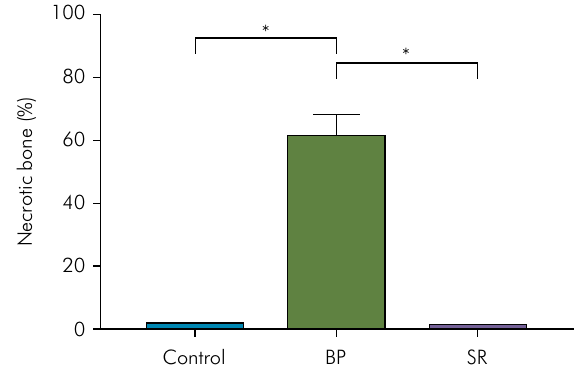
(Mean ± SEM) *p < 0.05 (Kruskal–Wallis, followed by Dunn’s test). Figure 6. Incidence of MRONJ based on rate of necrotic bone. Necrotic bone was present only in the BP group. No evidence of osteonecrosis was detected in control and SR groups.